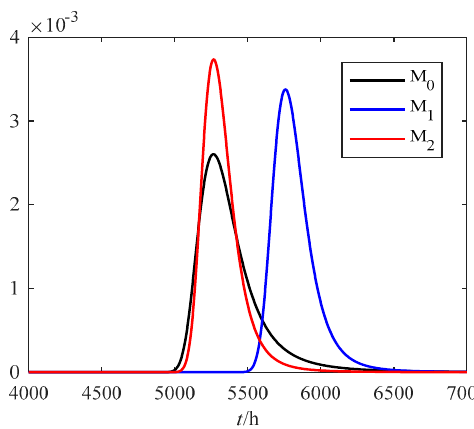
Figure 2. Comparison of PDF of lifetime at 65 °C for accelerometers.